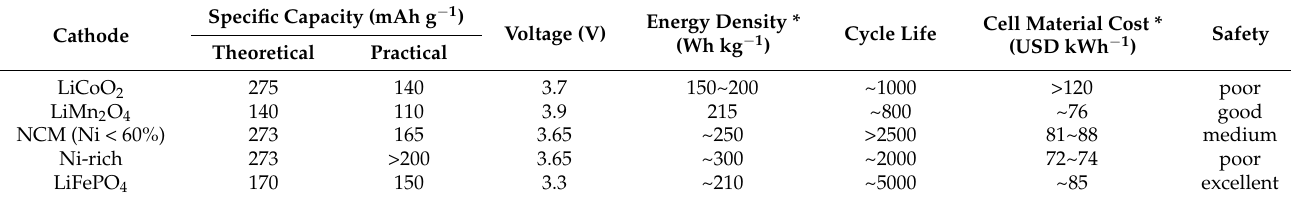
Table 1. A comparison of several commercial cathode